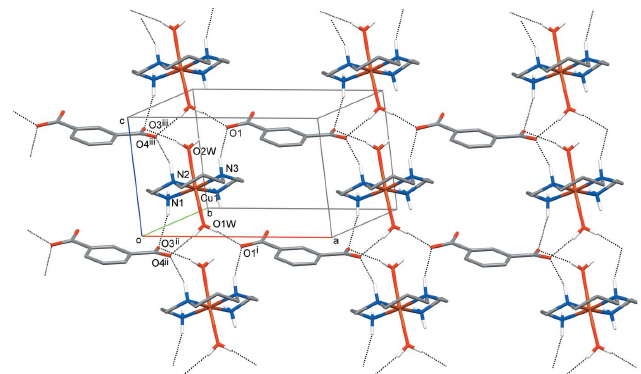
Figure 2 The hydrogen-bonded (dashed lines) sheets in I . C-bound H atoms and water molecule of crystallization have been